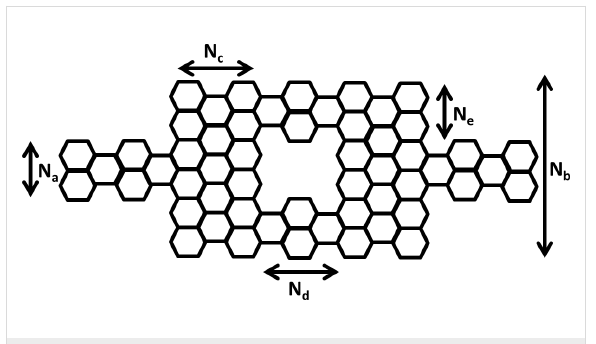
Figure 2: Graphene nanoribbon MZI structure (armchair